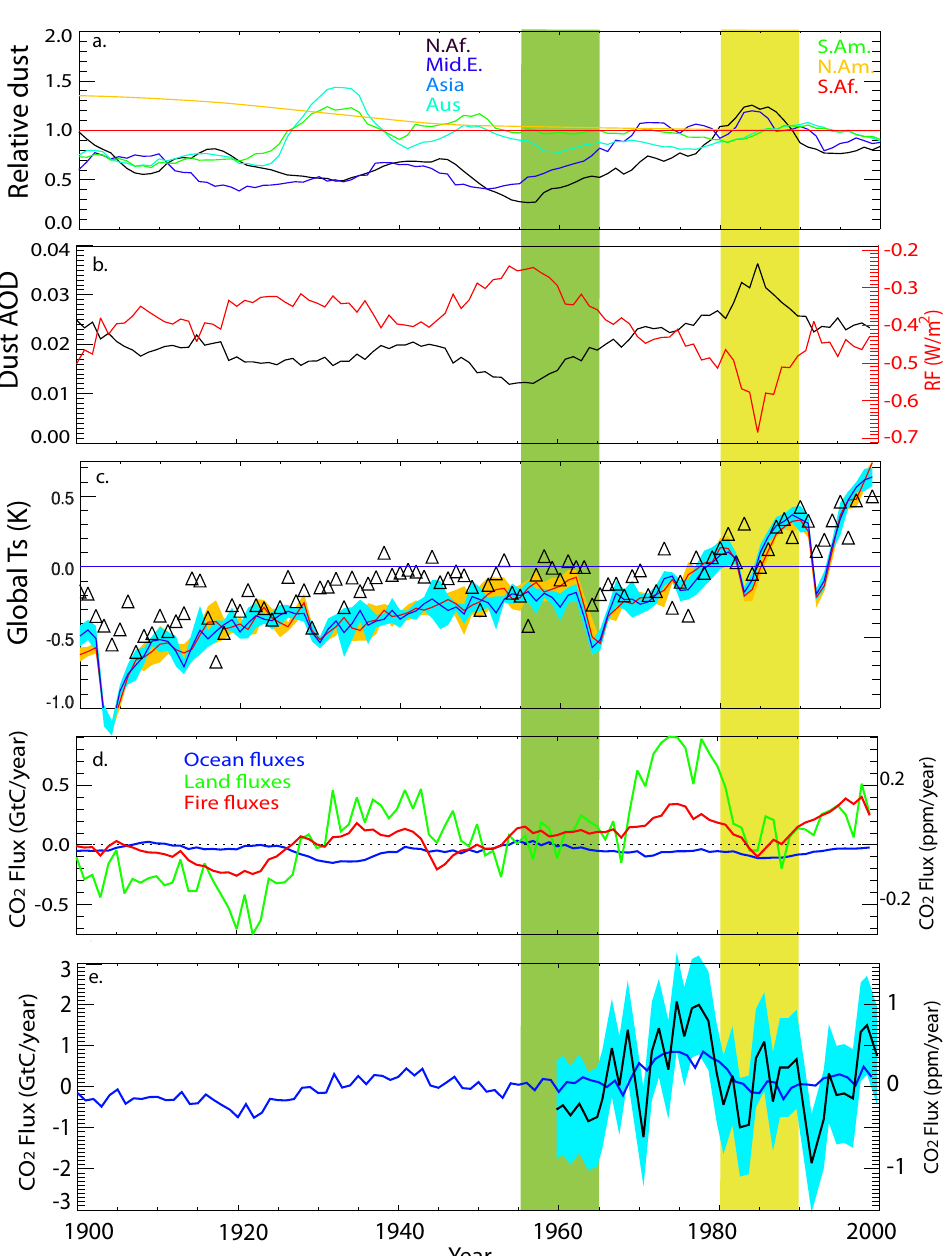
Fig. 3. The relative strength the dust source regions (normalized to 1 for each region for 1980–2000) as estimated from the observations (a) for North Africa (black), Middle East/Central Asia (dark blue), Asia (blue), Australia (cyan), South America (green), North America (yellow), and South Africa (red). The model estimated aerosol optical depth (AOD) (black) and change in instantaneous radiative forcing in W/m 2 (red) (b) . Globally averaged surface temperature change (relative to 1960–2000) for the mean of the atmospheric general circulation model simulations without dust (blue) and with dust (red) compared against the observed changes (black triangles) (c) . The variability in the ensemble simulations are shown as shaded areas for the no dust (cyan) and dust (gold) simulations. Net release of carbon dioxide in GtC/year deduced from the change in dust deposited to oceans (blue), land areas (green) and the fire portion of the land flux (red) (d) : note that positive means a flux into the atmosphere. The net CO 2 flux anomalies into the atmosphere from the land and ocean model simulations computed here including dust variability (blue line) compared to the residual CO 2 flux (black) and uncertainty (cyan shading) computed from simulations not including dust variations from a recent synthesis (LeQuere et al., 2009). The shaded blue region represents the uncertainties in the residual CO 2 flux (LeQuere et al., 2009). The background green and yellow boxes represent the least dusty time period (green: 1955–1964) and the most dusty time period (1980–1990) during the 20th